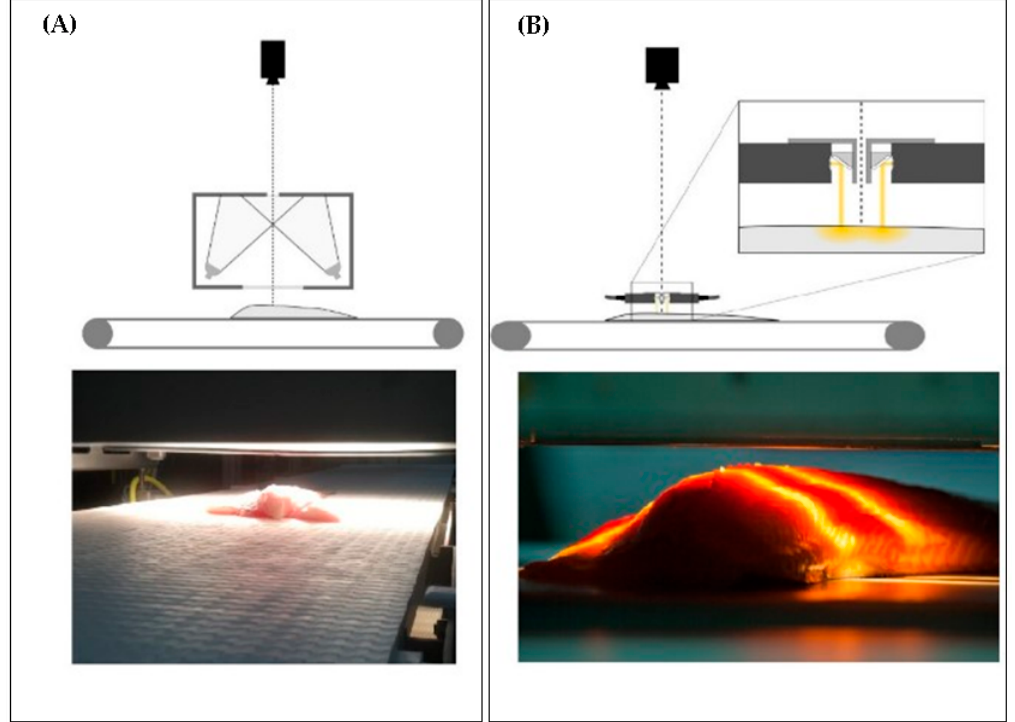
Figure 1. Example of application of spectroscopic measurements (hyperspectral imaging setups) used to scan fish samples on conveyer belts with ( A ) diffuse reflectance mode and ( B ) interactance mode. Reproduced in compliance with CC BY license from Ref. [32].